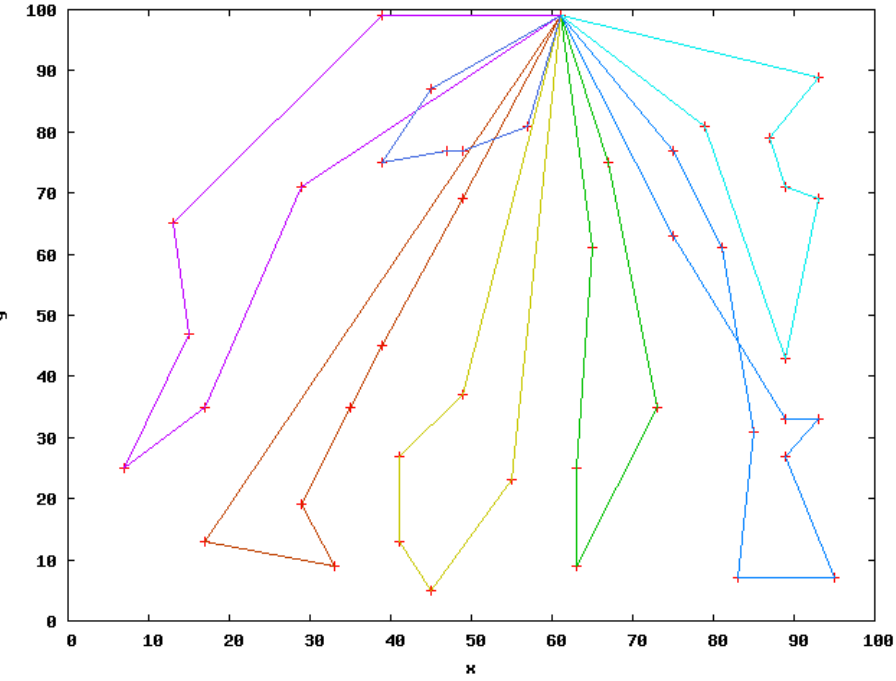
Figure 15. Mutation domination experiment—dominant mutation, Augerat set A solution, 6.75% worse than the optimal